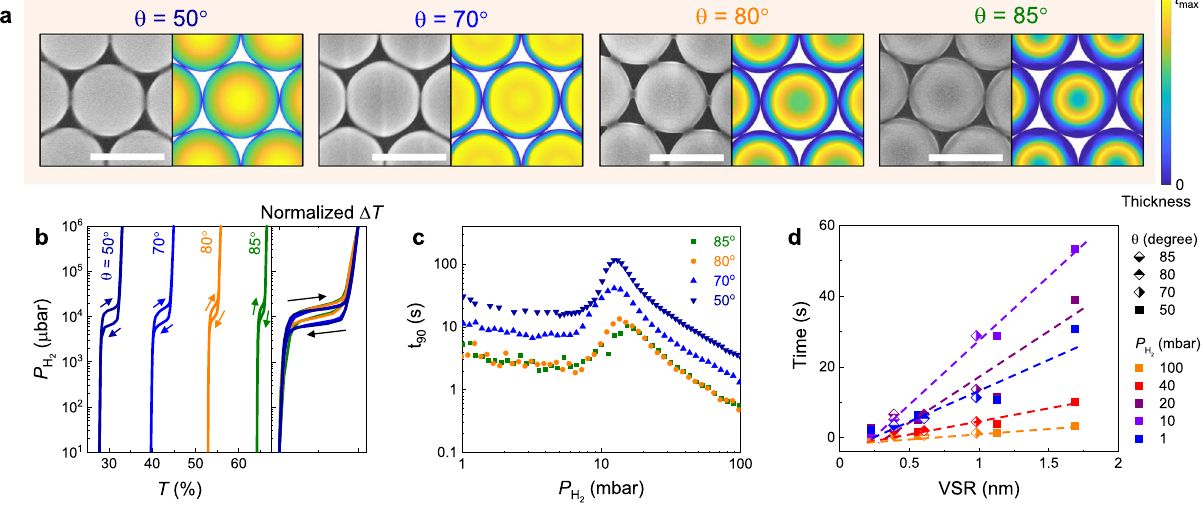
Fig. 3 Pd NP θ sensors with different θ . a Top-view SEM images (left) and corresponding simulated morphologies (right) of pure Pd NP samples, 15 fabricated with vapor incident angle of θ = 50°, 70°, 80°, and 85°, respectively. Scale bars correspond to 500 nm, and the color bar shows the Pd thickness distribution in the simulated hemisphere cap. b Optical hydrogen sorption isotherm of NP with different θ , extracted at Δ T ( λ ) maxima. Arrows denote the sorption direction. The panel to the right shows corresponding normalized Δ T ( λ ) hydrogen sorption isotherm of NP with different θ . c Response time of NP sensors with pulse of hydrogen pressure from 1 mbar to 100 mbar. d Response time of NP samples as a function of volume-to-surface ratio of NP sensors, at different hydrogen pressure. Note that the optical isotherm data of NP 50 sample presented in Figs. 2c and 3b are identical, and response time data of 15 NP 50 sample presented in Figs. 2f and 3c are identical. 15